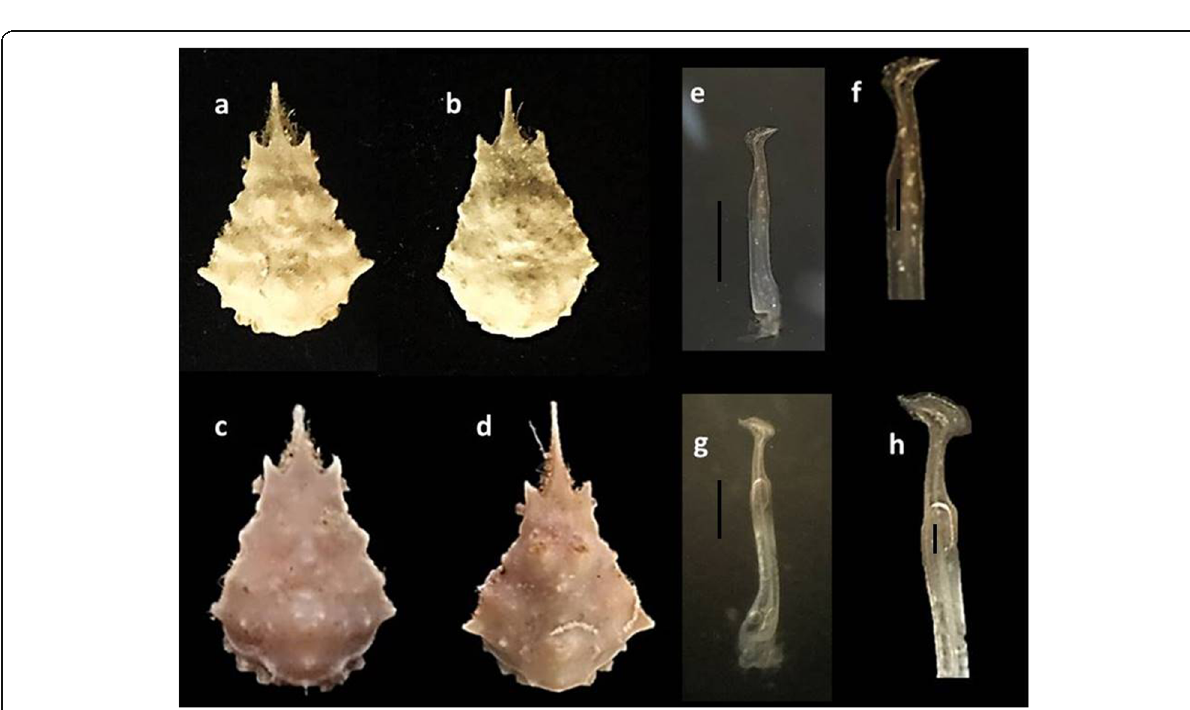
Fig. 2 M . monoceros . a – d Dorsal surface of carapace. e – h First male pleopod. a RCAZUE-Crus-Br.26151.07. b RCAZUE-Crus-Br.26151.06. c , e , f RCAZUE-Crus-Br.26151.03. d , g , h RCAZUE-Crus-Br.26151.05. Scale